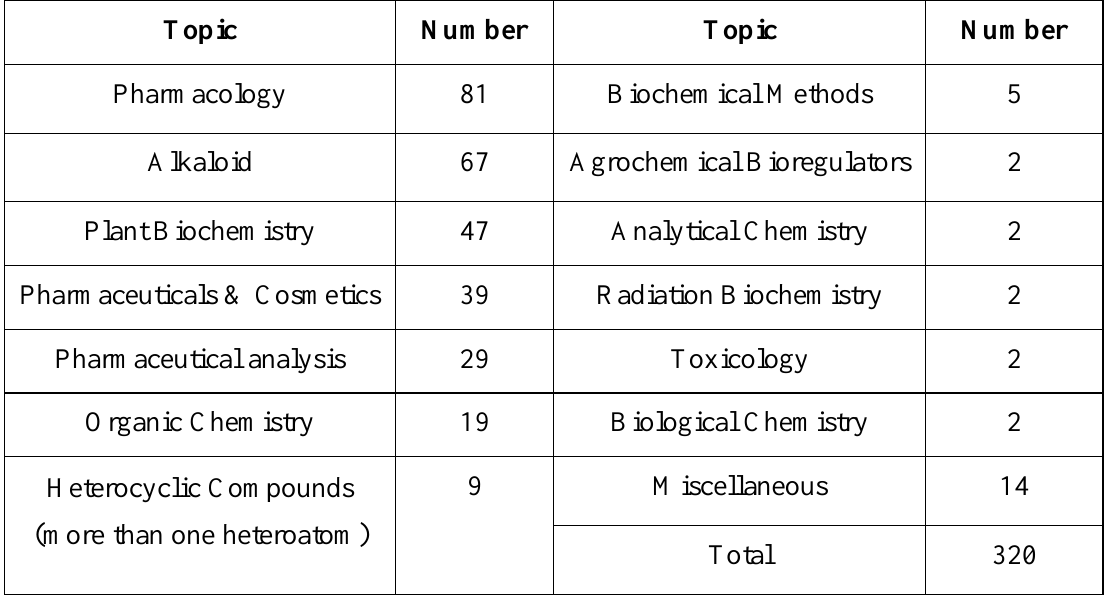
Table 2 . Classification of rutaecarpine references by CA